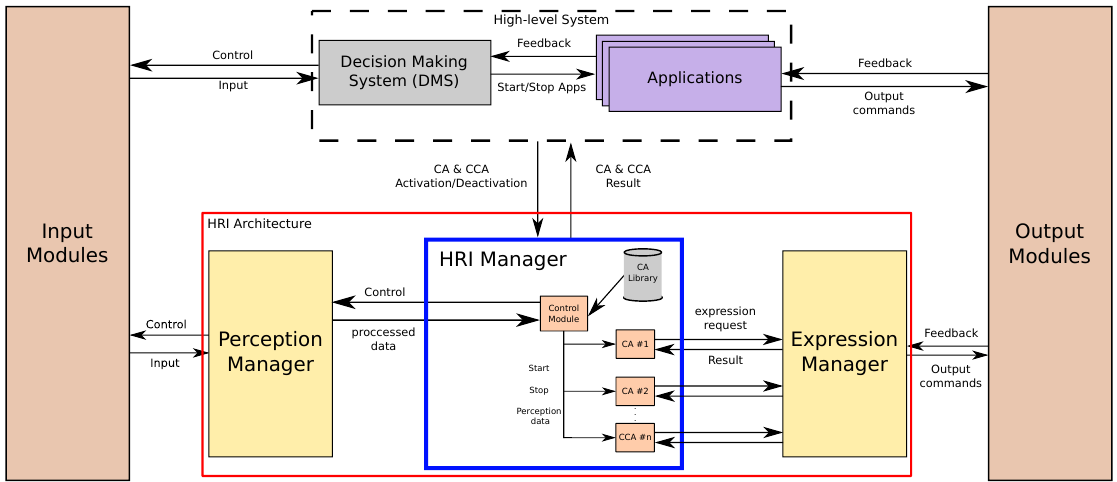
Figure 2. Black-box view of the human–robot interaction (HRI) Architecture (Red box) and its communications with the rest of the robot’s software architecture. This paper focuses on the central piece of the architecture, the HRI Manager (blue